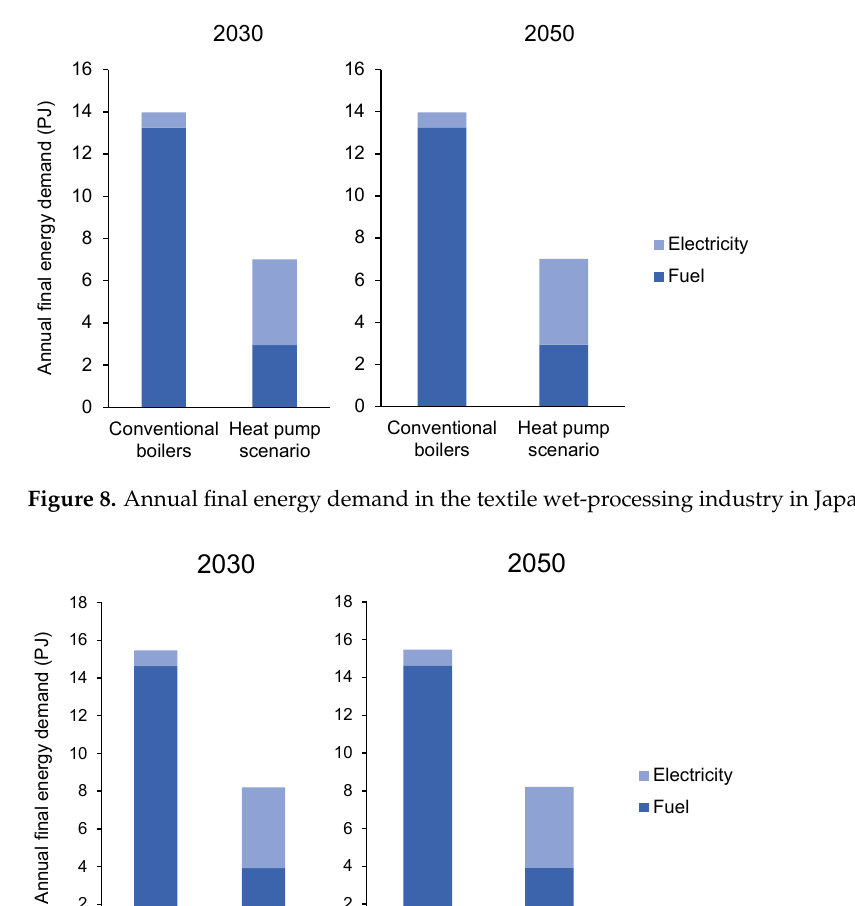
Figure 7. Annual final energy demand in the textile wet-processing industry in China .